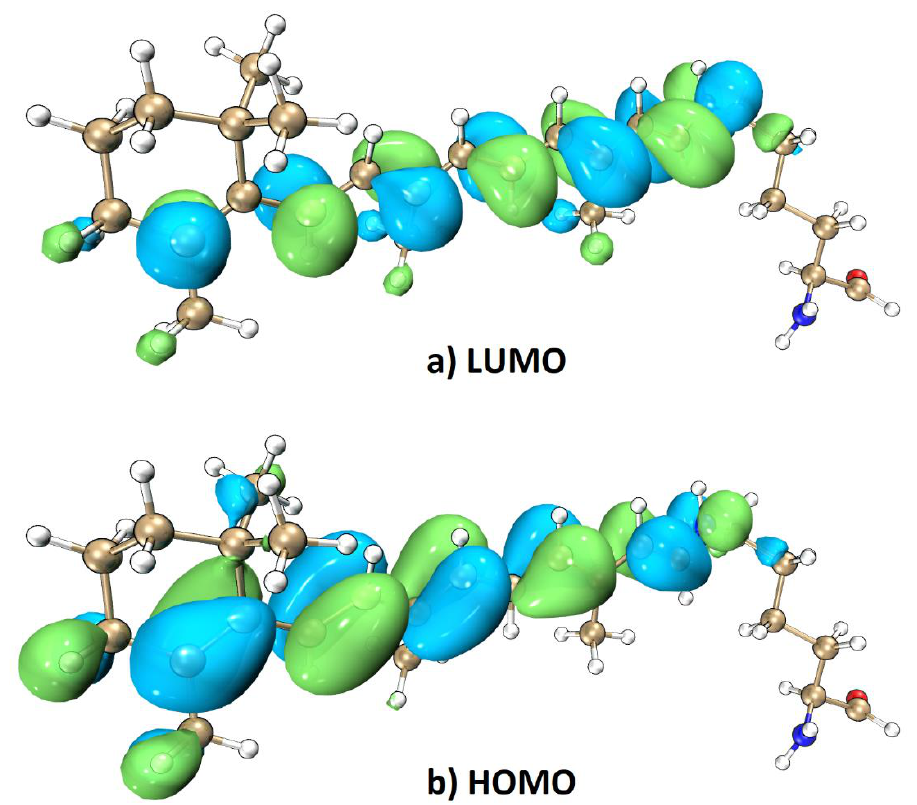
Figure 8. Representative snapshot of PR105D from QM/MM MD simulation and calculated LUMO ( a ) and HOMO ( b ) orbitals at the TD-B3LYP/6-31G* level where LYR231 was subjected to quantum mechanical treatment with background charges of the remaining part of PR105D. Charge transfer process of electron excitation from HOMO to LUMO [55,56].